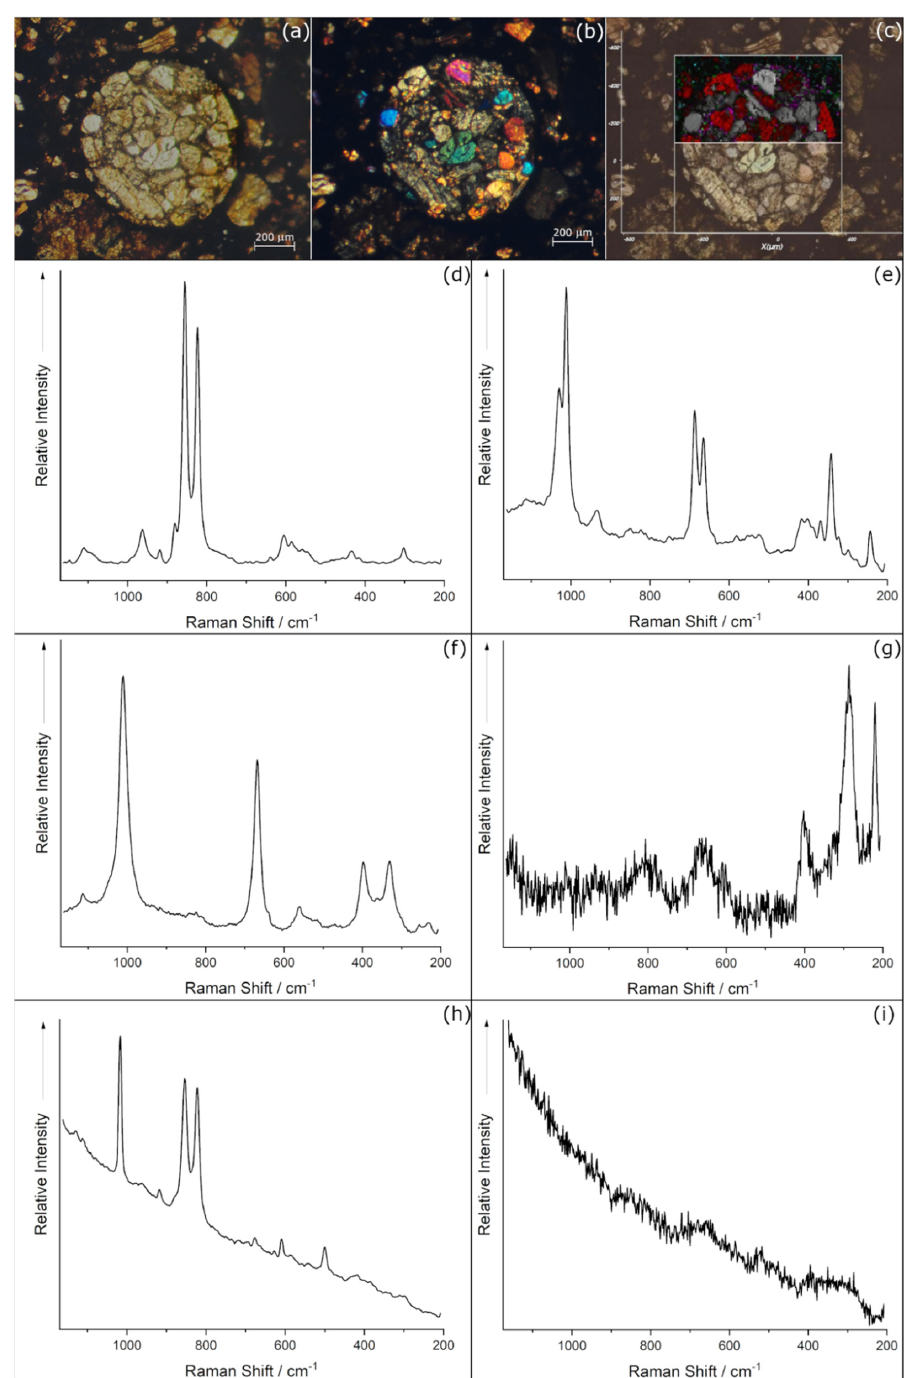
Figure 2. OM images and µ-RM of chondrule A: ( a ) OM image plane-polarized transmitted light; ( b ) OM image cross-polarised transmitted light; ( c ) µ-RM results overlapped on the OM image, the white thick square indicates the mapped area and the different colours correspond to the different mineral phases, identified on the basis of the Raman spectra: ( d ) Forsterite (grey), ( e ) Enstatite (red), ( f ) Diopside (purple), ( g ) Hematite (green), ( h ) Anhydrite (blue), and ( i ) Raman spectrum without any bands, corresponding to the black areas in the map.